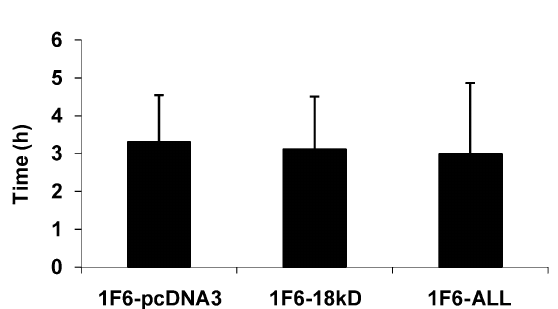
Fig. 2. Determination of VEGF mRNA half-life in 1F6-pcDNA3, 1F6-18kD and 1F6-ALL clones. Cells were treated with the tran- scription inhibitor actinomycin D after an initial exposure time of one h (from t = − 1 h till t = 0). Thereafter, VEGF mRNA levels were determined by light-cycler RT-PCR at 1 h, 2 h, 3 h, 4 h and 5 h. Half-lives were calculated in h. Bars represent mean values ± range of two independent experiments.